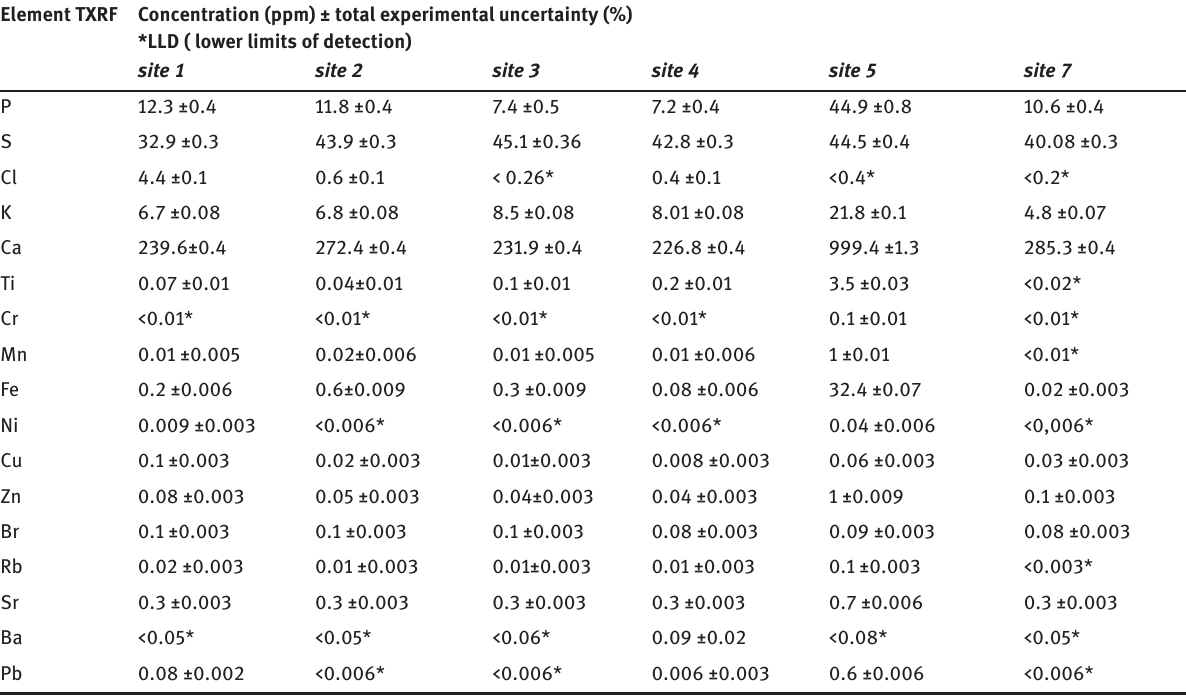
Table 3: Element concentrations in two water reservoirs A (sites 1-4) and B (site 5), and drainage ditch C (site 7) determined by TXRF method in ppm units with total experimental uncertainty (in %) (September 22 nd